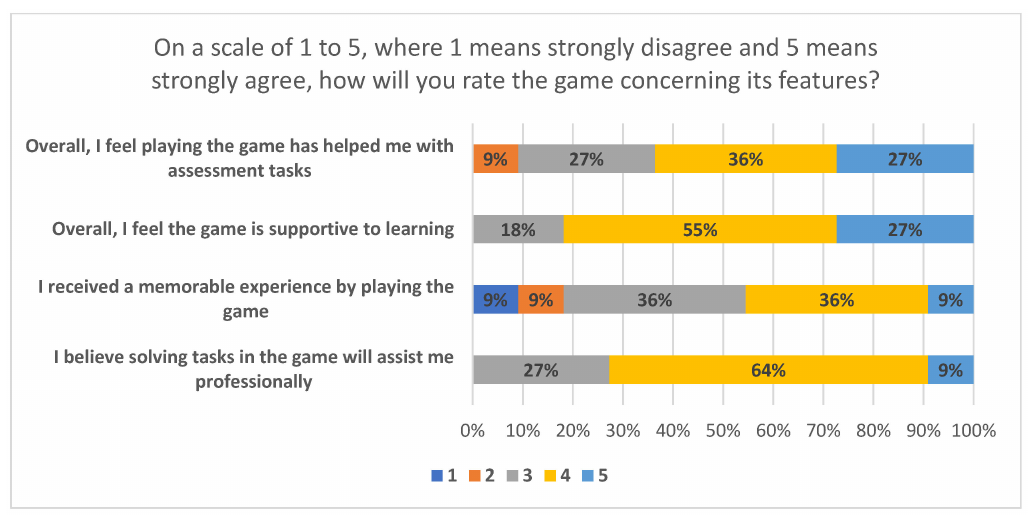
Figure 14. Respondents’ rating concerning the game’s